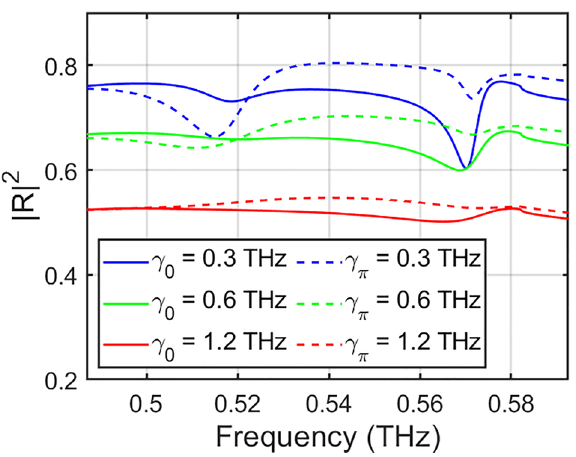
Figure 5: Numerical calculations of the reflection spectrum of phased double-Floquet-graphene layers at d ≈ 0.17 mm for different ∕ ( mE values of loss rates 𝛾 Δ 𝜙 = e 𝑣 2 )from 0.3 THz (blue), 0.6 THz F F (green), to 1.2 THz (red) based on a conservative electron mobility m = 100 × 10 3 , 50 × 10 3 , 25 × 10 3 cm 2 ∕ ( V ⋅ s ) [44]. Solid and dashed lines correspond to Δ 𝜙 ≈ 0 and Δ 𝜙 ≈ 𝜋 , corresponding to the preferential even and odd mode excitations respectively. The ( ) = 0.3 eV, W = e 2 E ∕ 𝜋ℏ 2 = 0 . 035 THz , parameters are E F , 0 D , 0 F , 0 f m = Ω∕ 2 𝜋 ≈ 0 . 16 THz , and 𝑣 F = 9.5 × 10 7 cm ∕ s [38], which correspond to the fermi level, Drude weight, modulation frequency, and fermi velocity of the charge carriers,